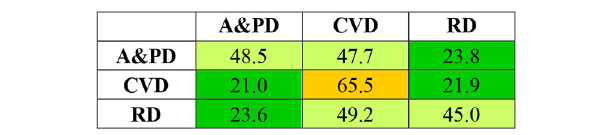
Respiratory disease